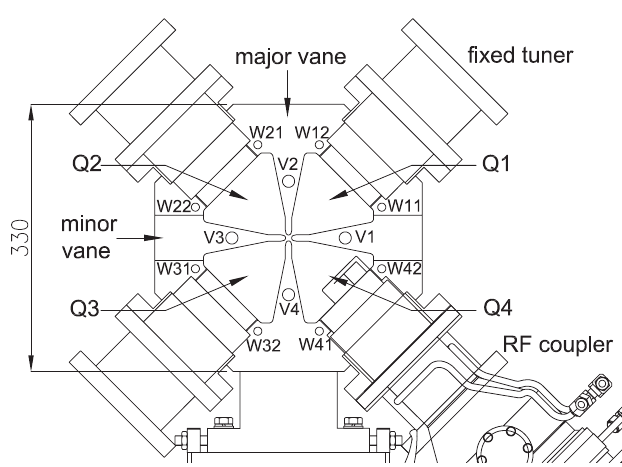
FIG. 2. Cross-sectional view (viewed from upstream) of RFQ